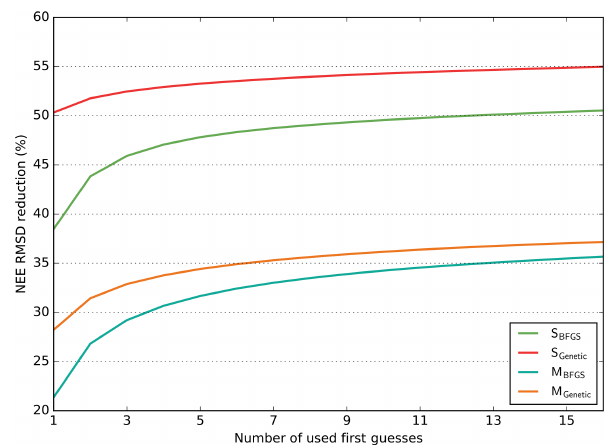
Figure 3. Model–data RMSD reduction (in %) obtained for the NEE fluxes as a function of the number of runs performed with ran- dom first-guess parameter values (for each configuration, S BFGS , S Genetic , M BFGS and M Genetic ) . For each number of first guesses ( x axis) all possible combinations across the 16 optimisation tests (i.e. 16 first guesses) are considered and the maximum RMSD re- ductions are calculated; the mean of these maxima is reported on the y axis. The results are averaged across all sites for each config-